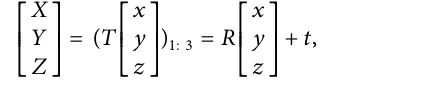
Frontiers in Energy Research |